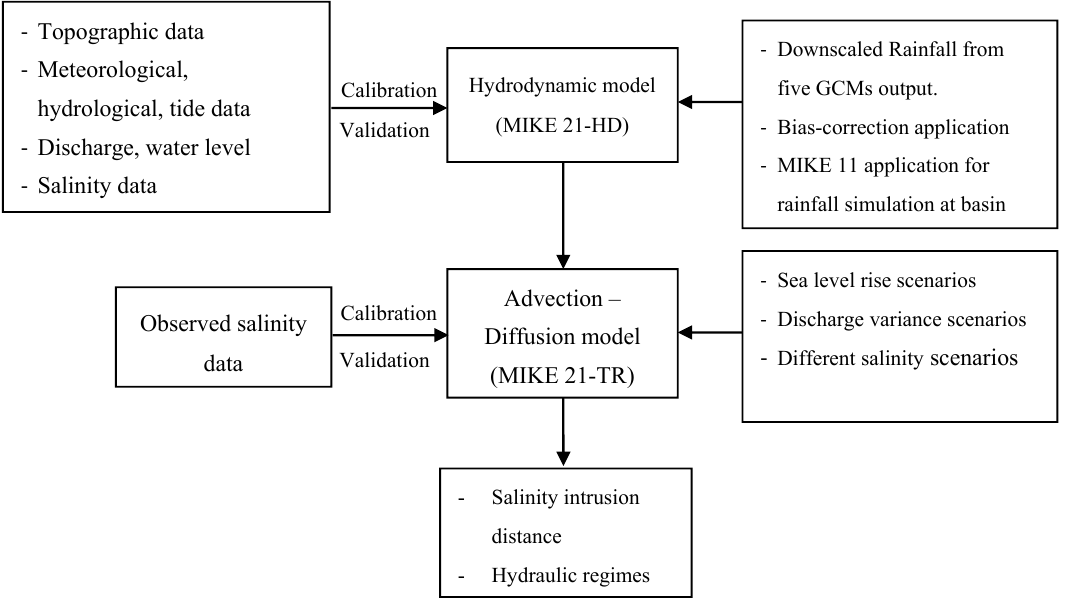
Figure 4. Schematic of the modelling framework for this study.